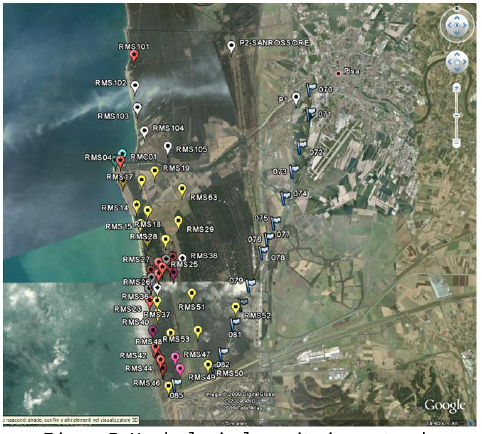
Figure 5. Hydrological monitoring network